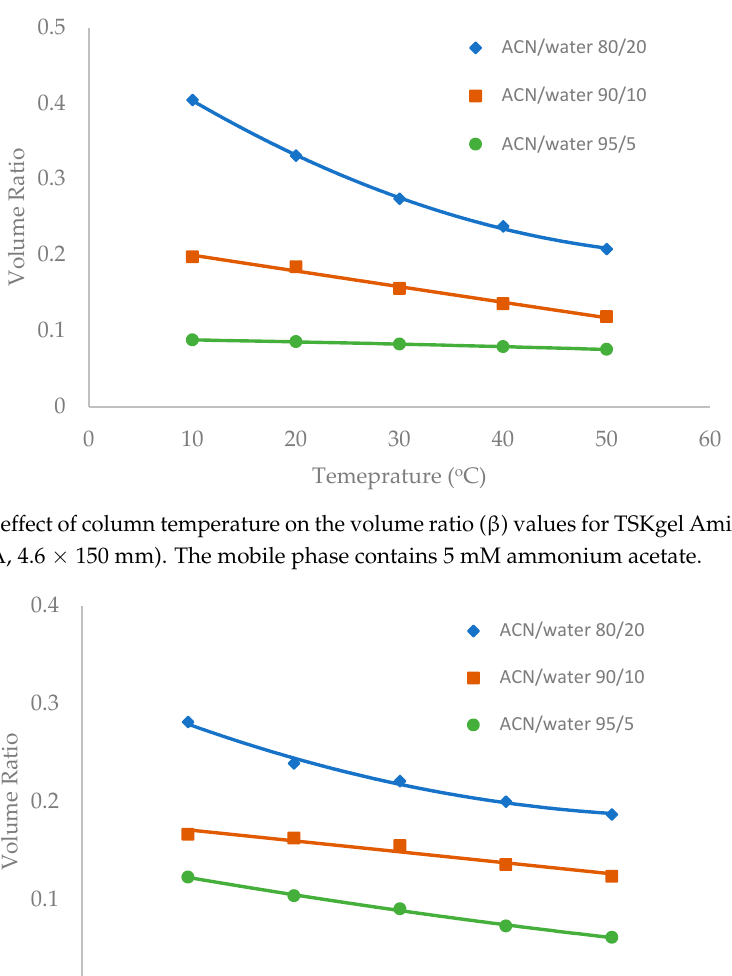
8 of 11 Figure 5. The effect of ammonium acetate concentration on the volume ratio values ( β ) for LUNA HILIC (3.0 µm, 187 Å, 4.6 × 150 mm). Column temperature is 25 °C. Temperature was observed to have an influence on the toluene elution time in our previous study [10]. The temperature effect was further investigated in this study in the mobile phase containing multiple levels of acetonitrile (80%, 90%, and 95%). Figures 6–8 show the volume ratio values for three stationary phases (TSKgel-Amide 80, ZIC-HILIC-3, and LUNA HILIC) in the temperature range of 10 to 50 °C. In general, increasing temperature leads to a decrease in the volume